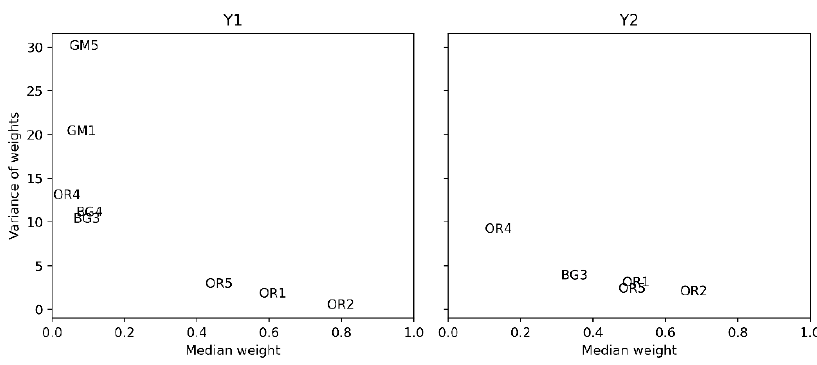
Fig. A4.4: Median and variance of resulting sample